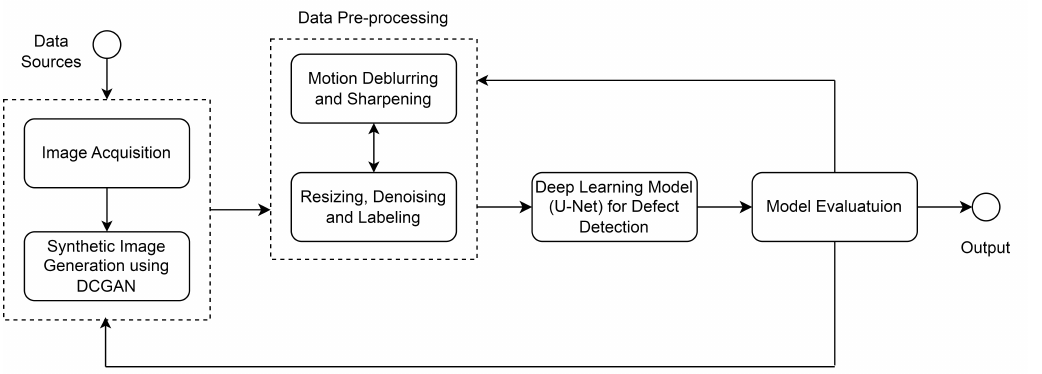
Figure 1. The deep learning framework for aircraft engine defect detection.